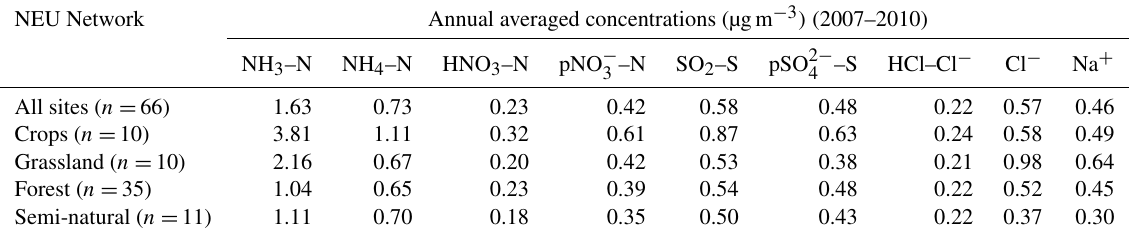
Table 4. Annual averaged concentrations of gas and aerosol concentrations, measured at all sites and at grouped sites classified according to each of the four ecosystem types in the NEU DELTA ®